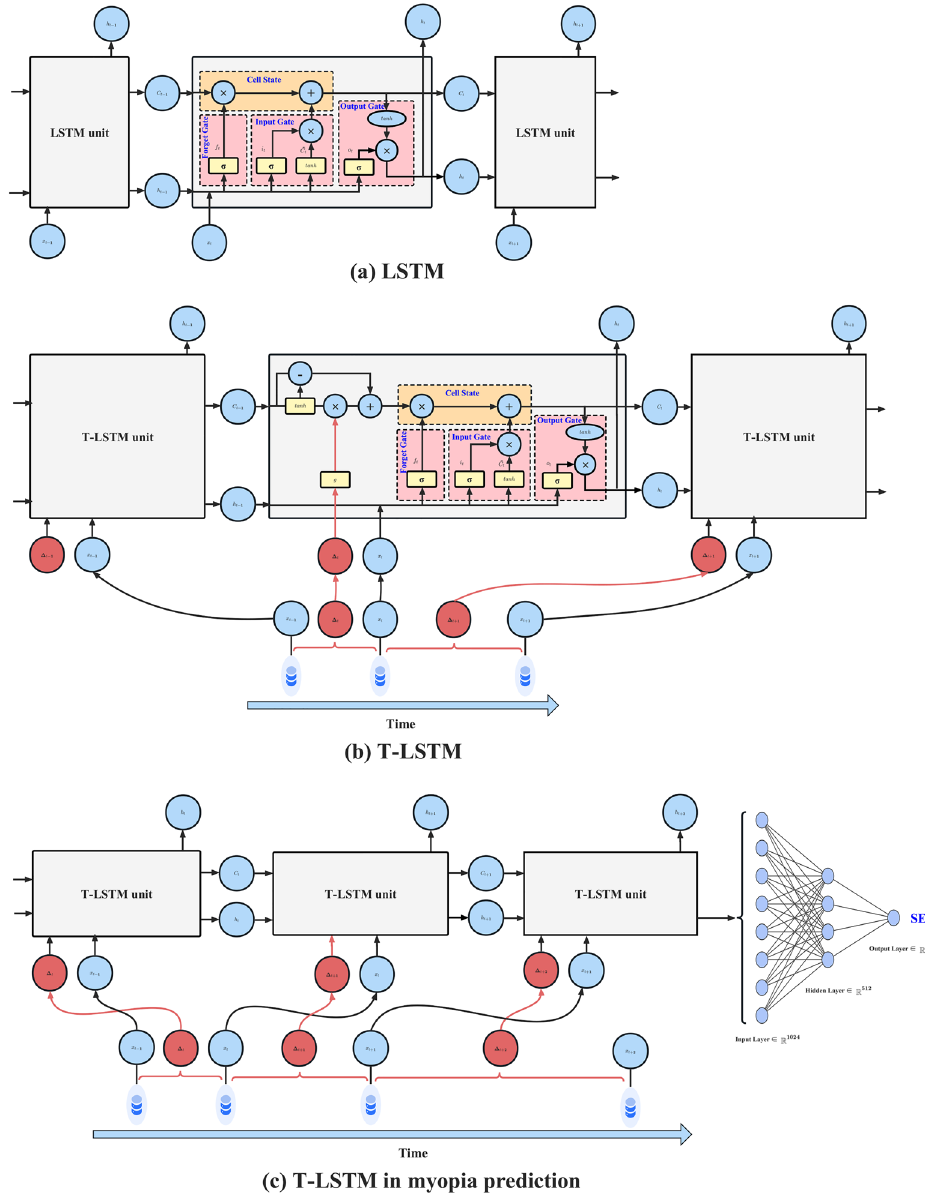
Figure 2. The structure of LSTM, T-LSTM and T-LSTM in myopia prediction, where x denotes the temporal input data, C is the cell state representing the long-term memory, h is the hidden state representing the short- term memory, (cid:31) t is the time interval between records x t and x t − 1 , σ is the sigmoid activation function, and tanh is the tanh activation